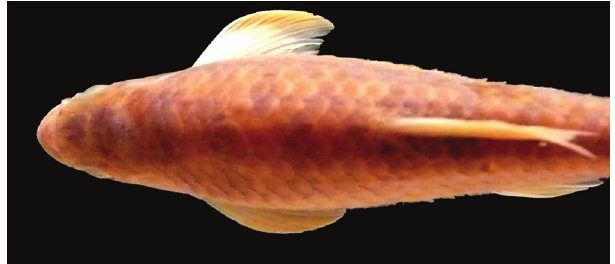
Fig. 6. Dorsal view of Parodon buckleyi , AMNH 233262, 66.3 mm SL, showing diagnostic pigmentation pattern of predorsal region.